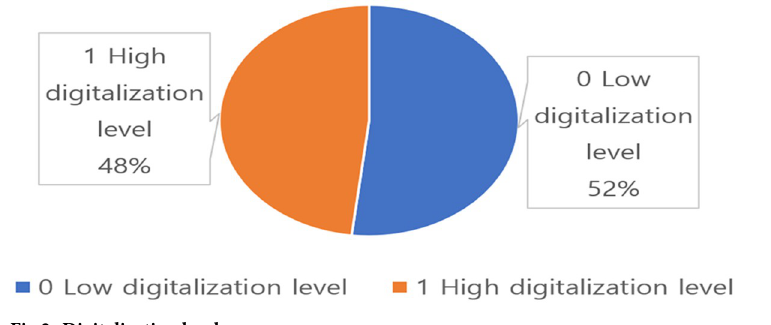
Fig 2. Digitalization